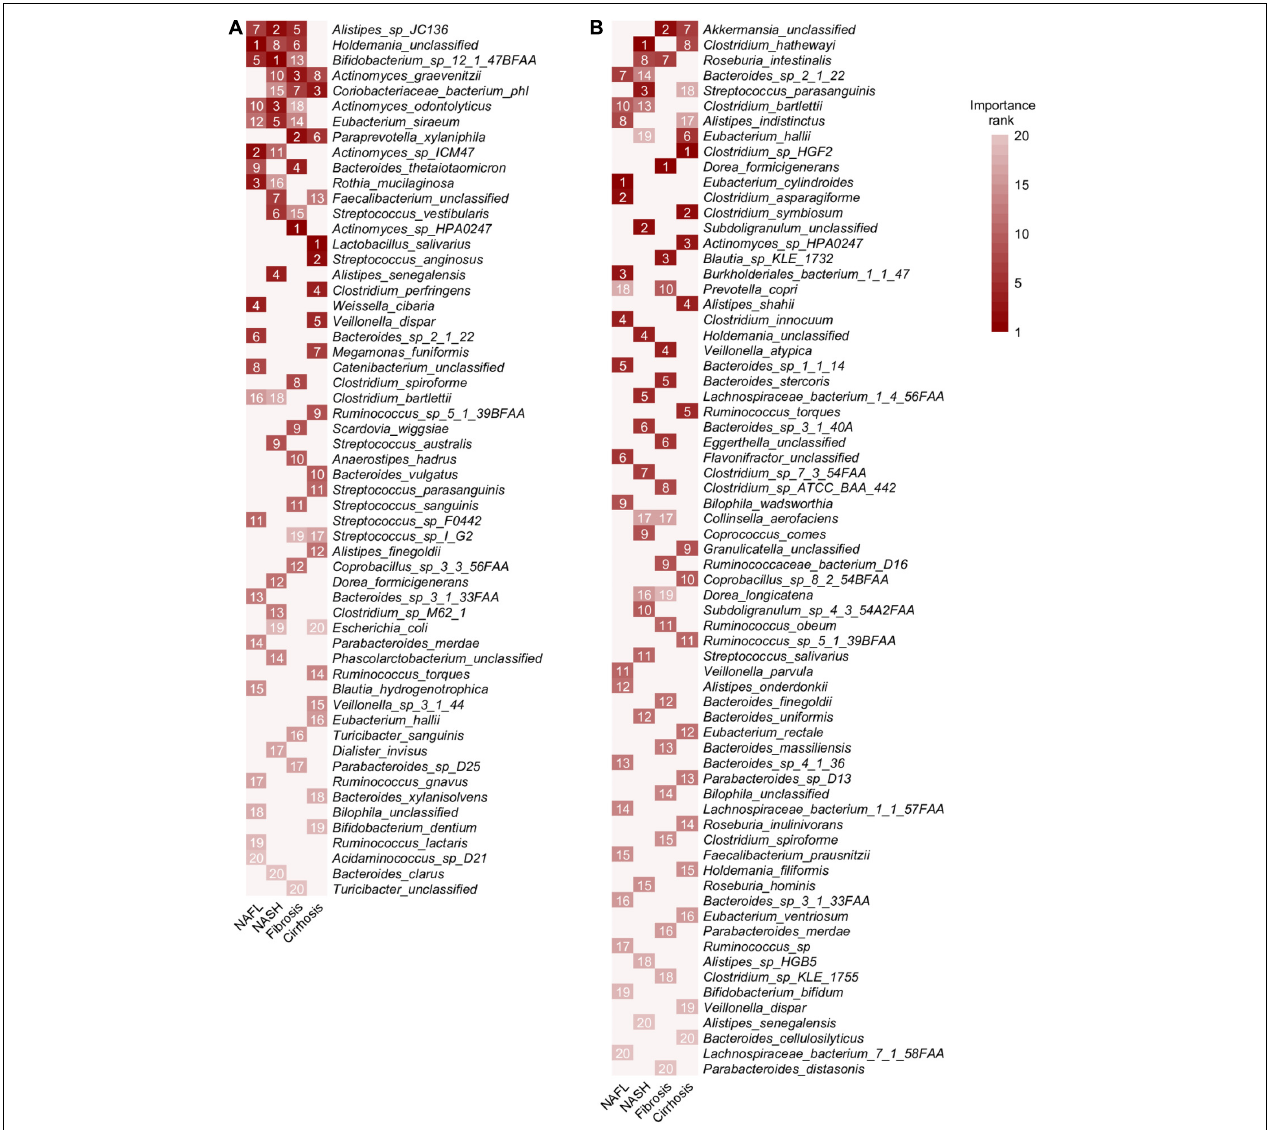
FIGURE 6 | Ranking relevance of each species in the predictive models for each stage. (A) The importance of each species for the prediction performance in each dataset estimated using stochastic gradient-boosting machine (GBM) learning models. (B) The importance of each species for the prediction performance of the models designed to distinguish one stage of NAFLD from other stages. Only species appearing in the 20 top-ranking features in at least one dataset are reported. HC, healthy controls; NAFL, non-alcoholic fatty liver; NASH, non-alcoholic